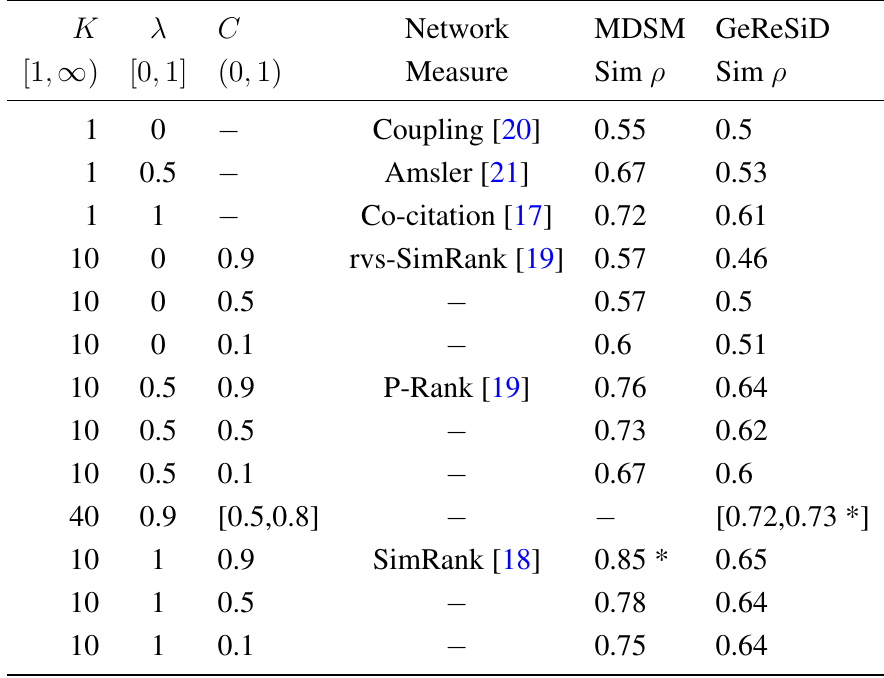
. Sim stands for net